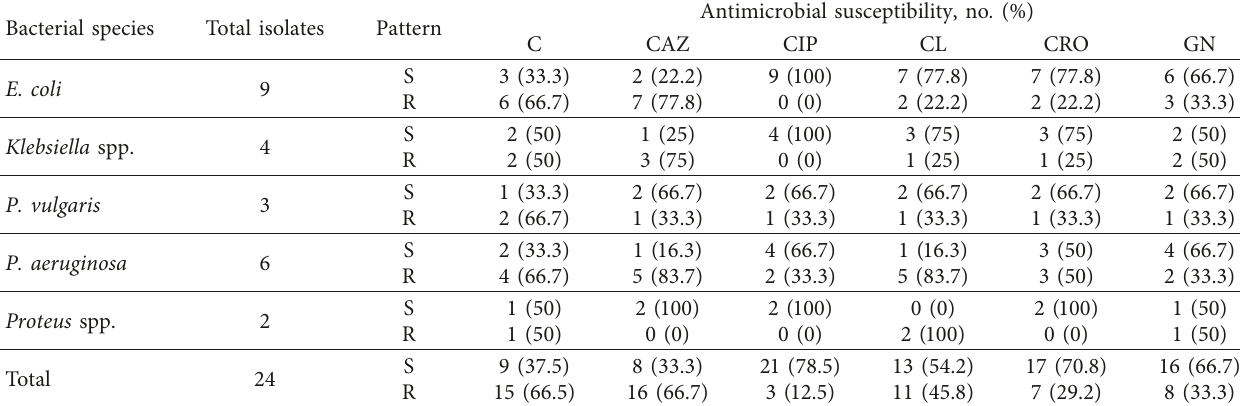
Table 4: Antimicrobial susceptibility pattern of Gram-negative bacteria isolated from NI-suspected patients at Hiwot Fana Specialized University Hospital, Eastern Ethiopia, March 2017 to July 2017. Bacterial